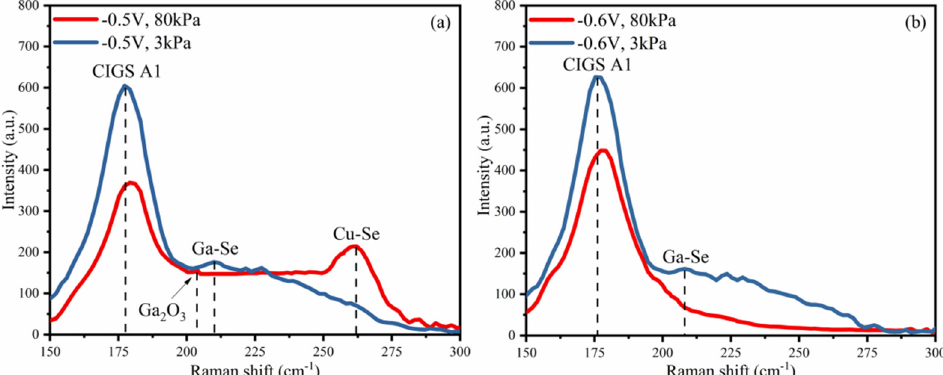
Figure 11. Raman spectra of CIGS thin films prepared at pressures of 80 kPa and 3 kPa and at potentials of ( a ) − 0.5 V and ( b ) − 0.6 V.